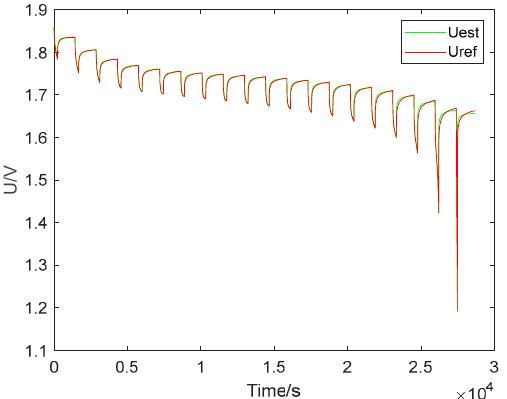
Figure 9. The voltage prediction curves of DUKF.